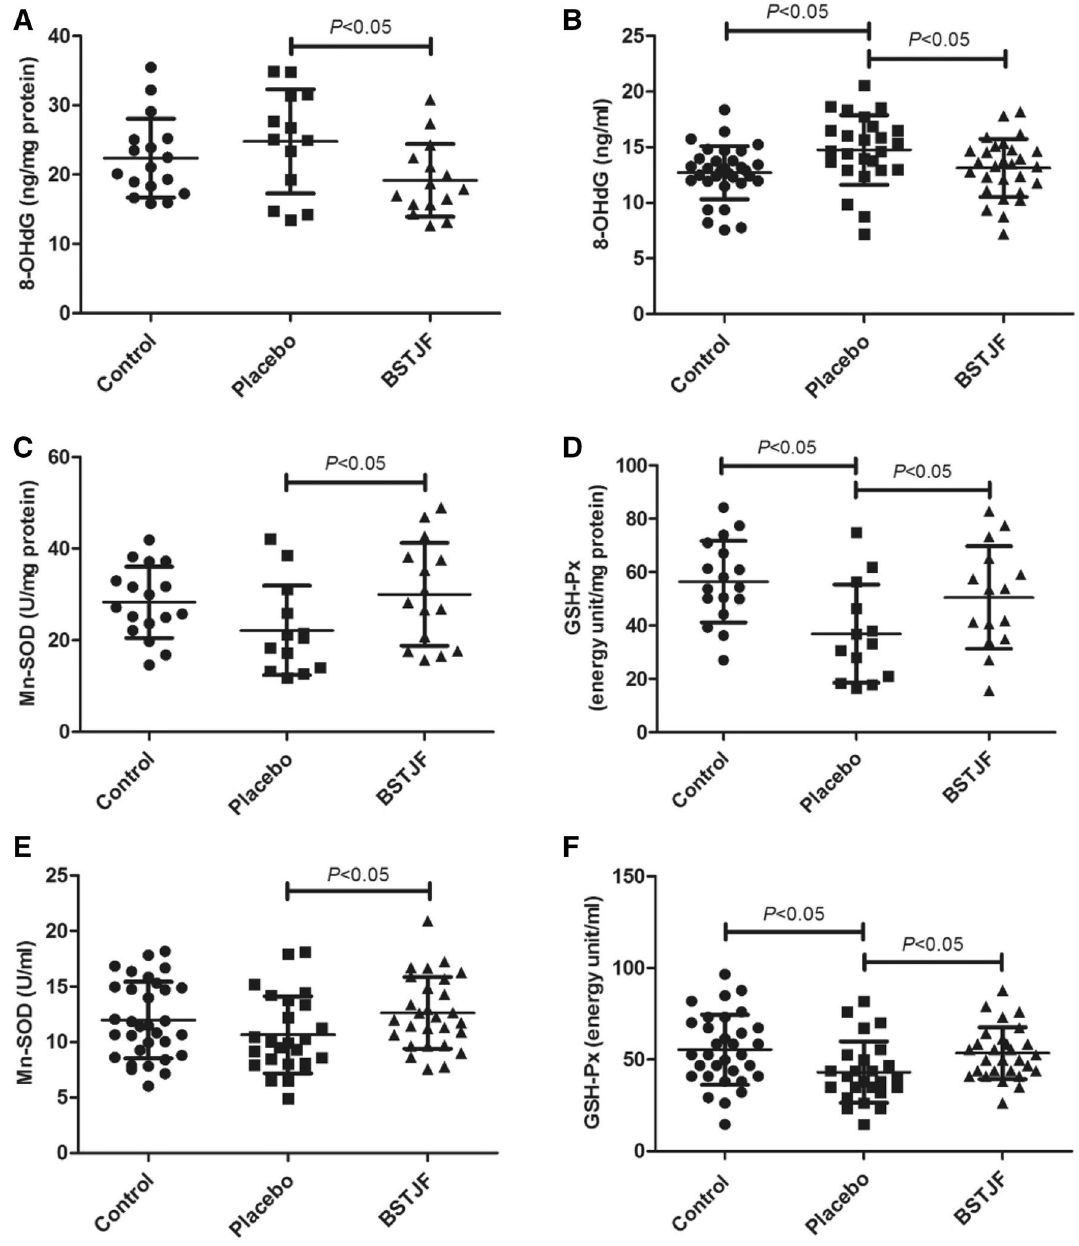
Figure 3. Comparison of oxidative stress markers in the ovarian GCs and FF. A , B 8-OHdG levels in GCs and FF. Antioxidant enzymes Mn-SOD and GSH-Px activity levels in the ovarian GCs ( C , D ) and FF ( E , F ). a P < 0.05 versus the control group; b P < 0.05 versus the placebo group; Student’s t test was used to compare the two groups. GCs granulosa cells, FF follicular